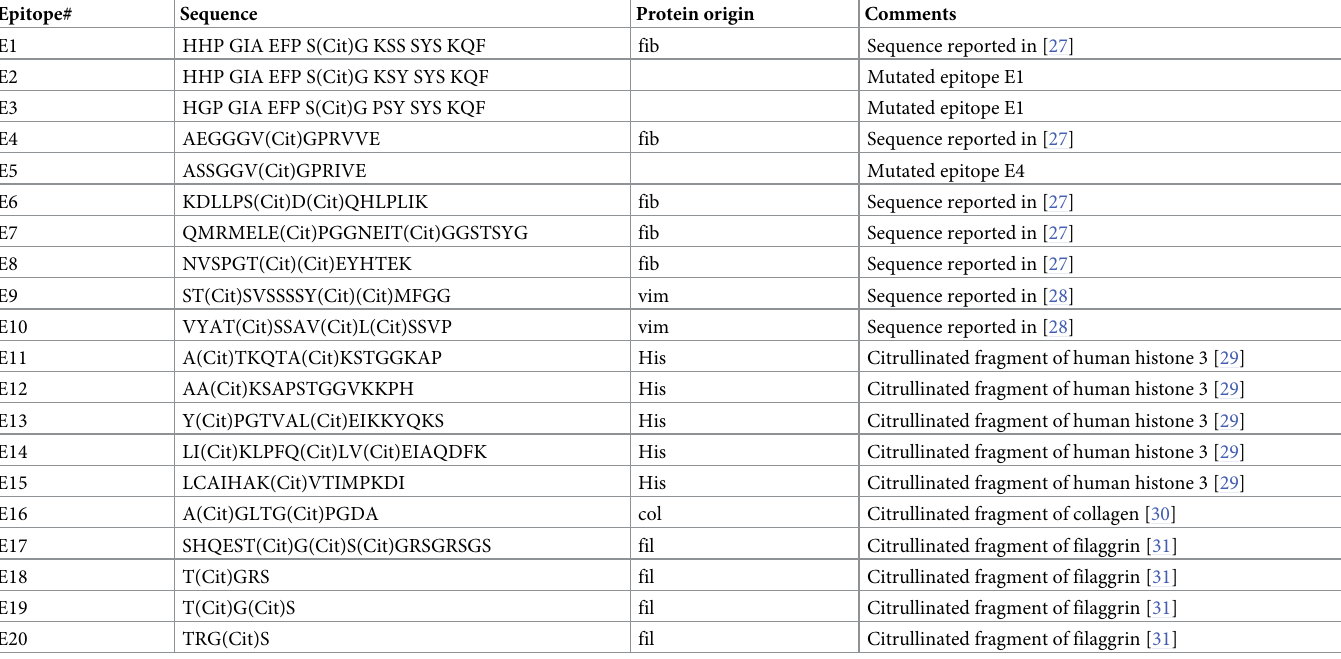
Table 1. Citrullinated peptide epitopes used in this study